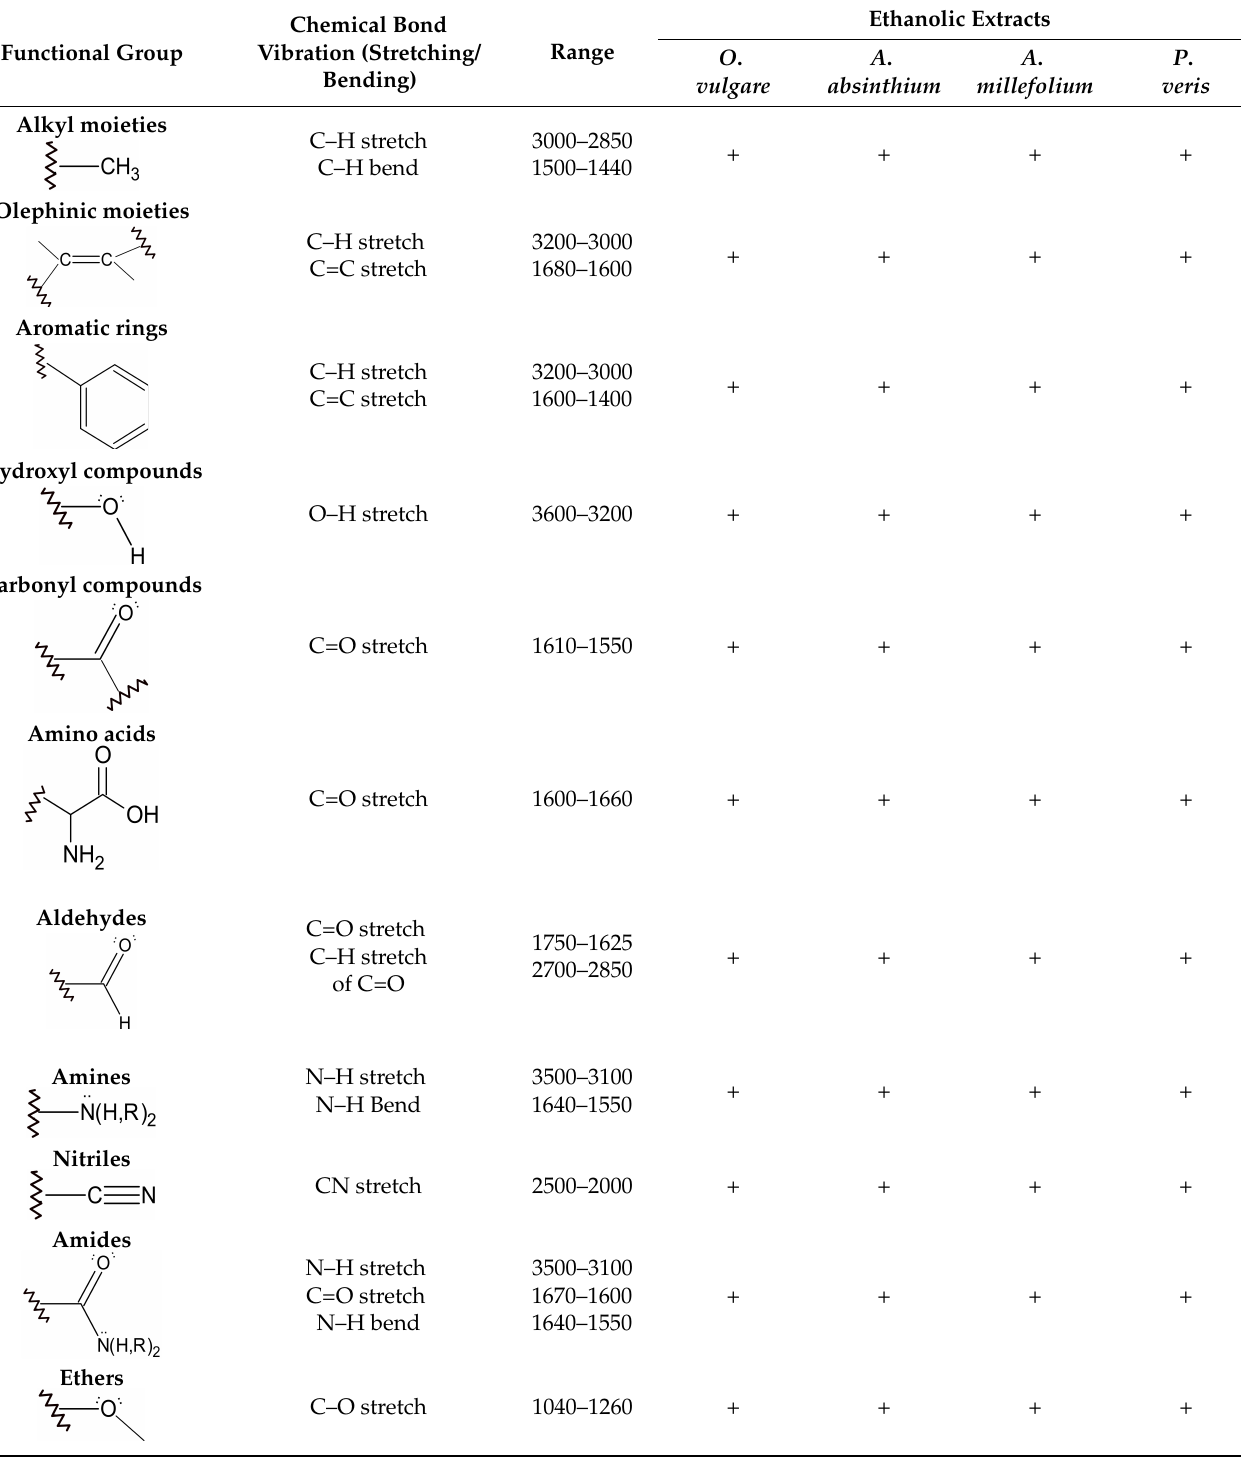
Table 2. The chemical functional groups found in the analyzed ethanolic plant